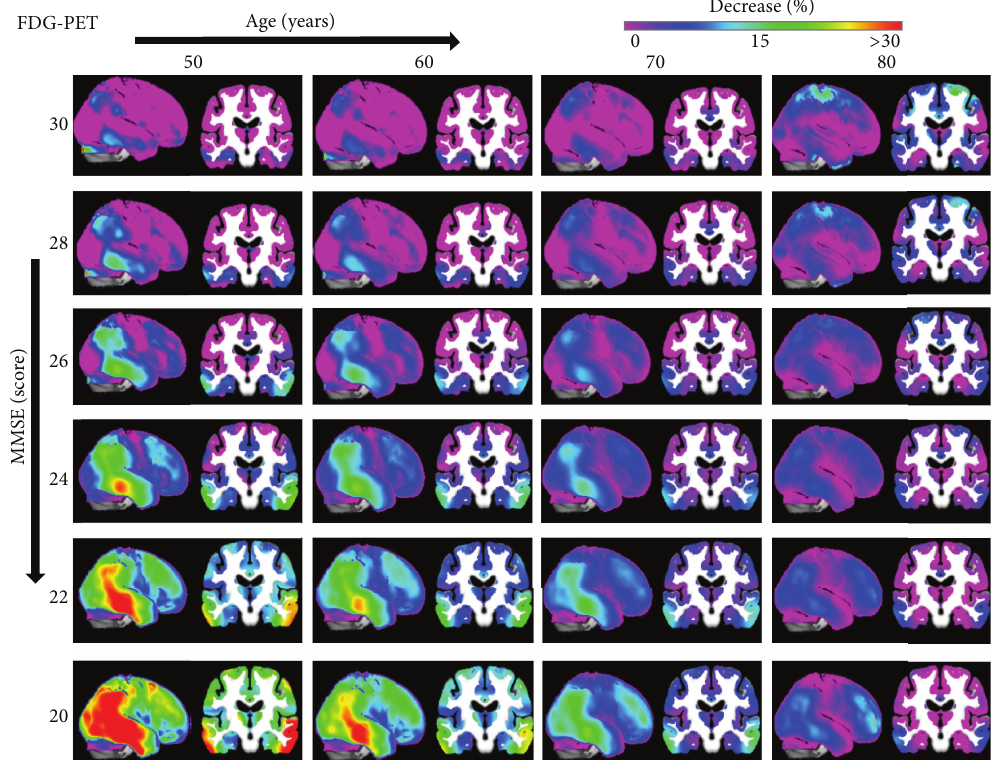
Figure 5: PET images using fluorodeoxyglucose (FDG) radiotracer. This model involves 3 variables: age, percent decrease in glucose metabolism, and Mini Mental State Examination (MMSE) scores in individuals diagnosed with AD using a healthy control group as baseline comparison (note that a MMSE score 27 or greater indicates normal cognition). In this study, the authors reported that an increase in AD severity is negatively correlated with grey matter volume, glucose metabolism, and MMSE scores. They also mention that the greater percent decrease in glucose metabolism in younger AD patients is both due to the dissociation between early- and late-onset AD and the effect of normal healthy aging in elderly patients resulting in a lesser percent decrease ([61], reprinted with